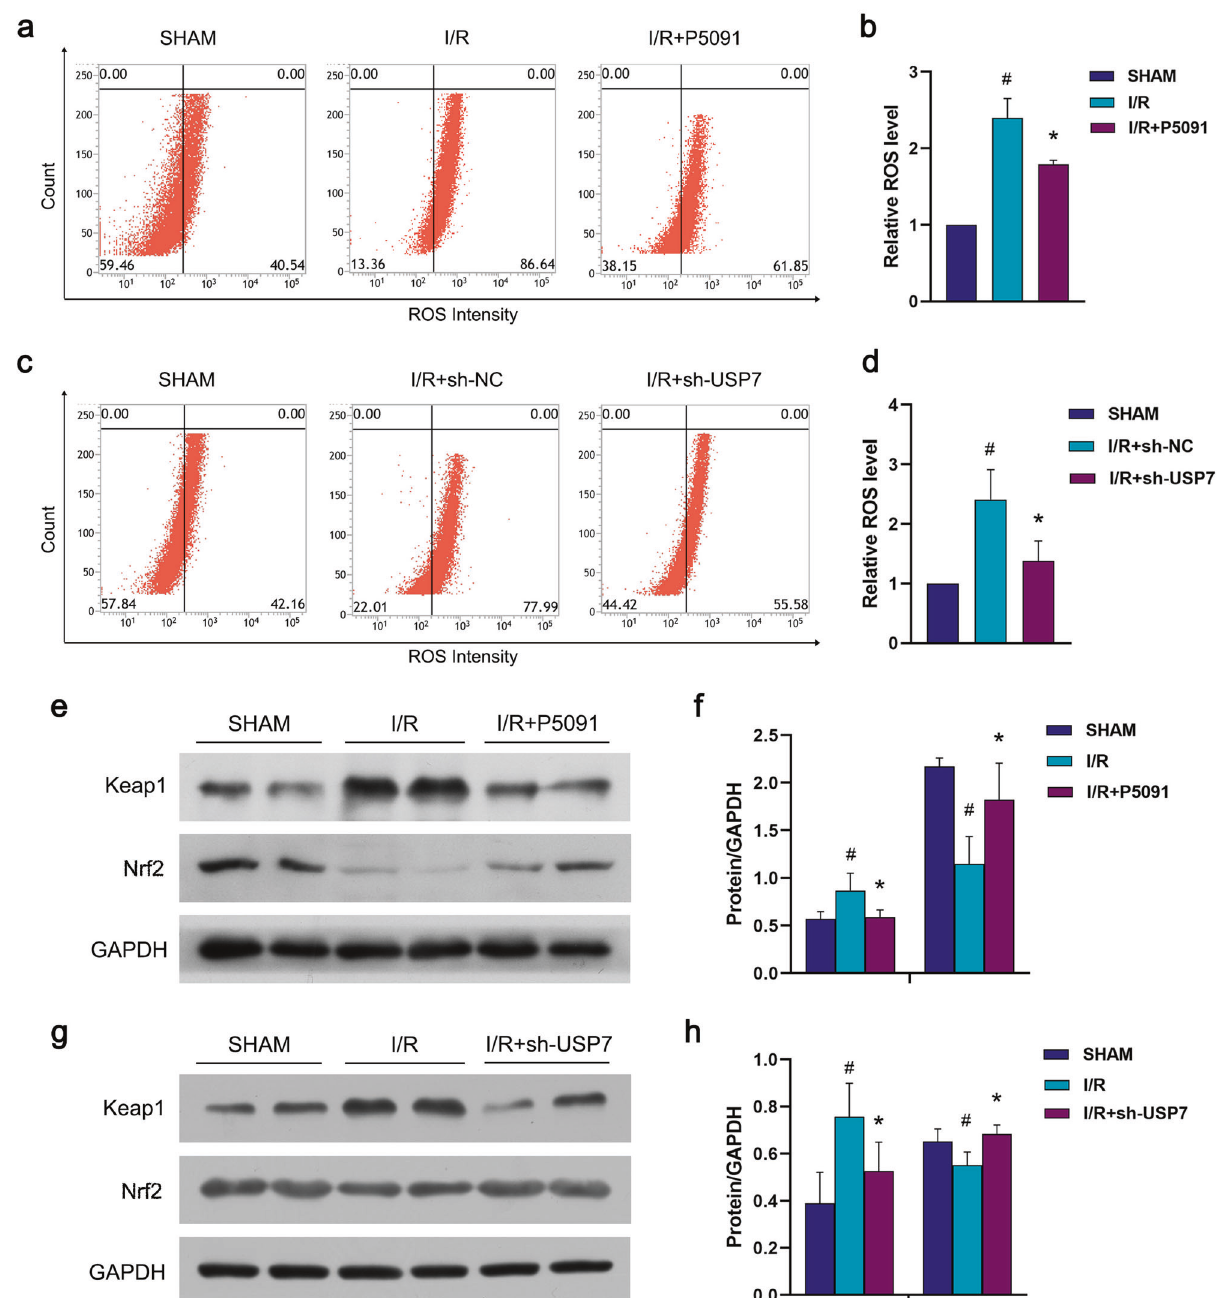
Fig. 6 USP7 regulates myocardial apoptosis through Keap1. a , b P5091 was intraperitoneally injected into mice for three consecutive days before 24 h of ischemia/reperfusion. Flow cytometry was used to measure the fl uorescence intensity of ROS. c , d sh-USP7 was injected into the myocardium of mice, and the myocardial ischemia/reperfusion model was established seven days later. ROS fl uorescence intensity was detected by fl ow cytometry. e , f The operation and treatment were the same as ( a , b ), Immunoblot was used to determine the amounts of Keap1 and Nrf2 proteins. g , h The operation and treatment were the same as ( c , d ), Immunoblot was used to determine the amounts of Keap1 and Nrf2 proteins. # Compared with the SHAM group, *Compared with the I/R group, P < 0.05, mean ± standard deviation ( n = 1000 rpm, and the supernatant was dscrarded. Samples were washed in solution was poured into the circle to cover the tissue and incubated for PBS and then centrifuged again to discard the supernatant. Finally, 22 min at 37 °C. The rupture fl uid should then be dropped over the tissue, samples were mixed with 200 µl of PBS and analyzed by FITC at 488 nm/ incubated at room temperature for 20 min, and then washed. After the 525 nm (BD FACSVerse, USA). slices had been gently dried, the buffer was poured dropwise to cover the tissue and incubated for 10 min at room temperature. Samples were then incubated at 37 °C for 2 h after adding the required amount of TDT TUNEL staining enzyme, dUTP, and mixing the buffer at a ratio of 1:5:50. The DAPI staining The heart was rapidly removed and fi xed in paraformaldehyde for 24 h, solution was then applied dropwise and incubated in the dark for 10 min after which 5 μ m paraf fi n slices were produced, and proteinase K working at room temperature. Samples were then mounted with an anti-